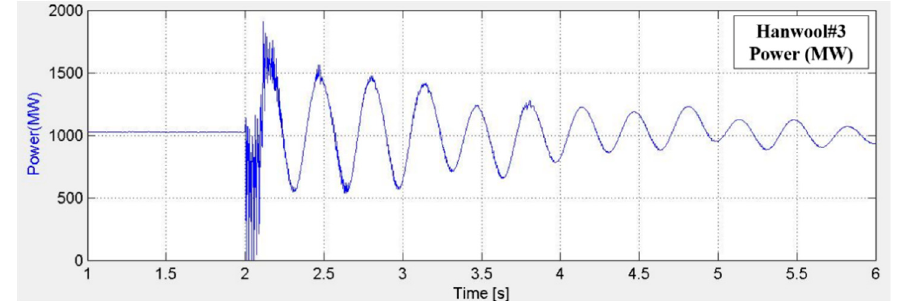
Figure 15. Time domain simulation result in light load of generator.